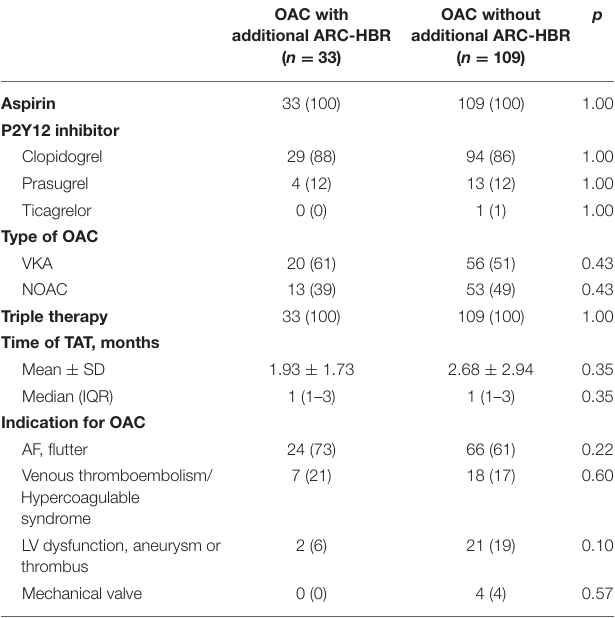
TABLE 3 | Antithrombotic regimen after PCI.